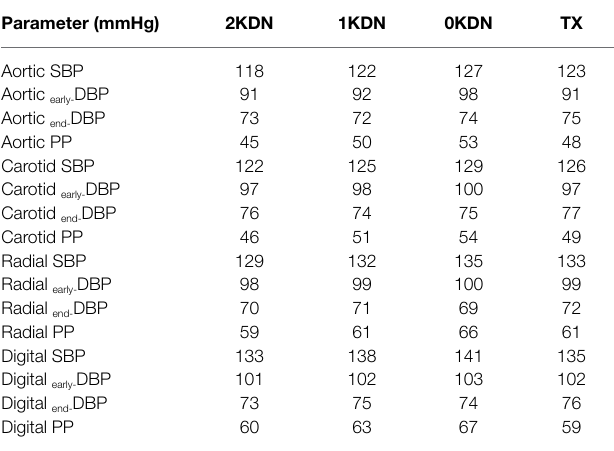
TABLE 3 | Changes in blood pressure with different kidney configurations using in silico distensibility data. Parameter